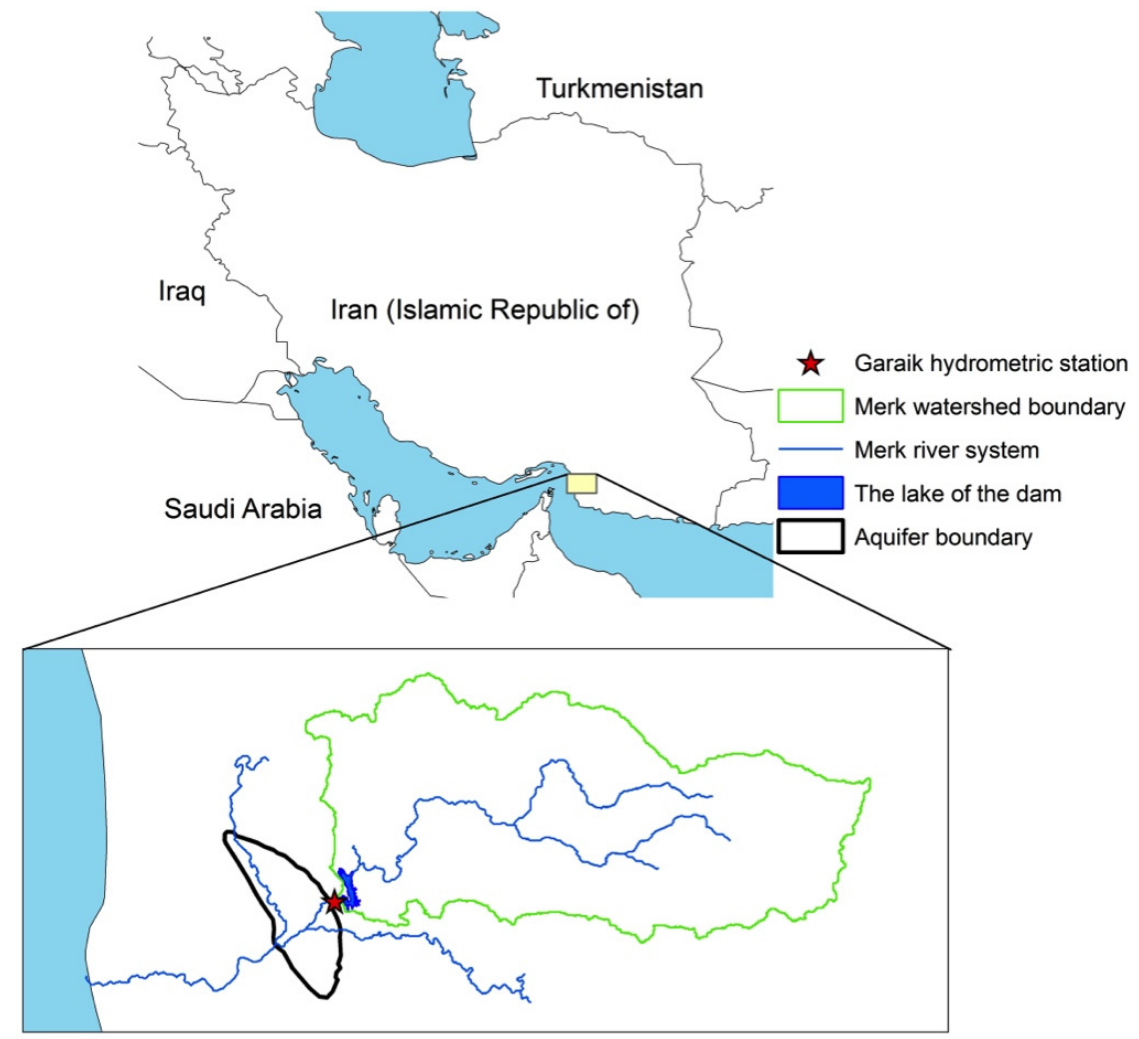
Figure 5. Location of the dam’s watershed, watershed boundary, aquifer boundary and the Garaik hydrometric